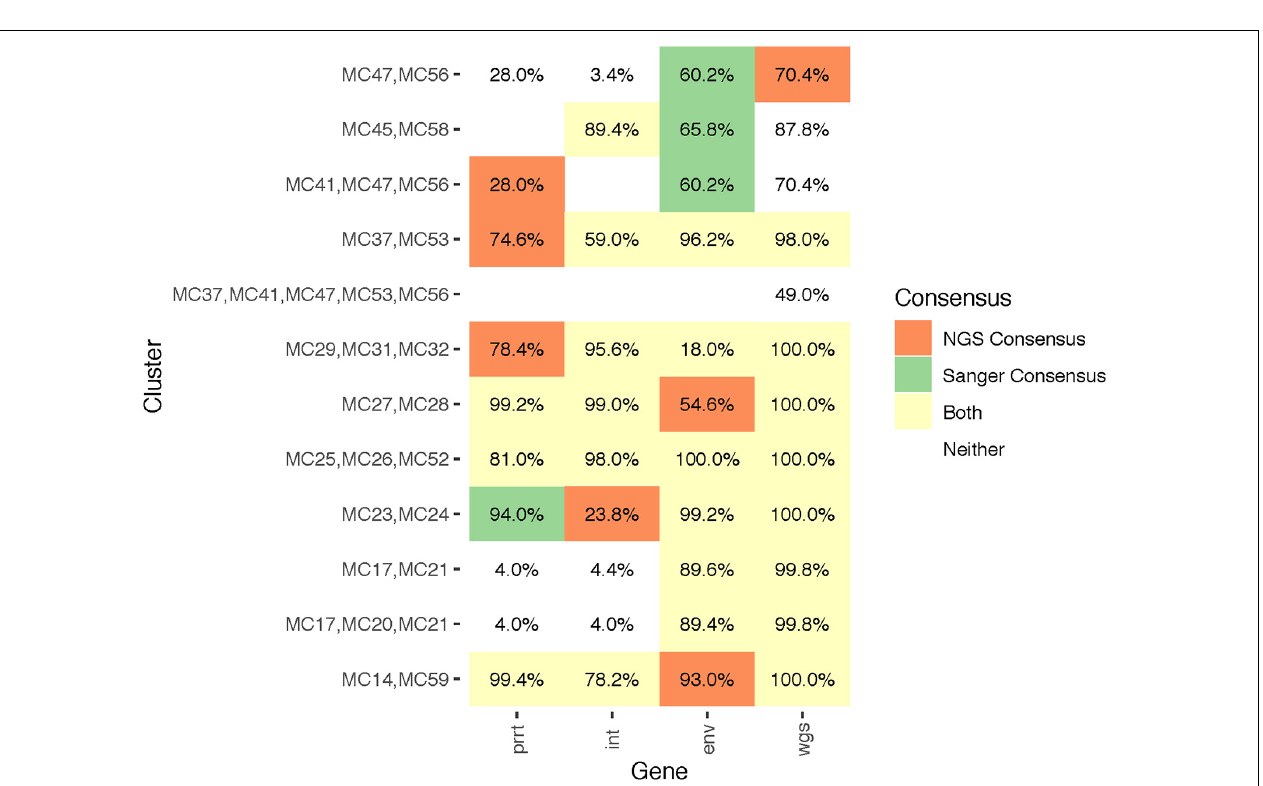
FIGURE 5 | Distribution of branch length sums across phylogenies. The figure demonstrates total branch lengths ( X axis), in each of the profile-sampled phylogenies ( Y axis and colors). The phylogenies from consensus sequences (dot and triangle) can lie at extreme values within these distributions, both when considering the lengths across all branches (top) and the lengths across only the branches at the tips (bottom).